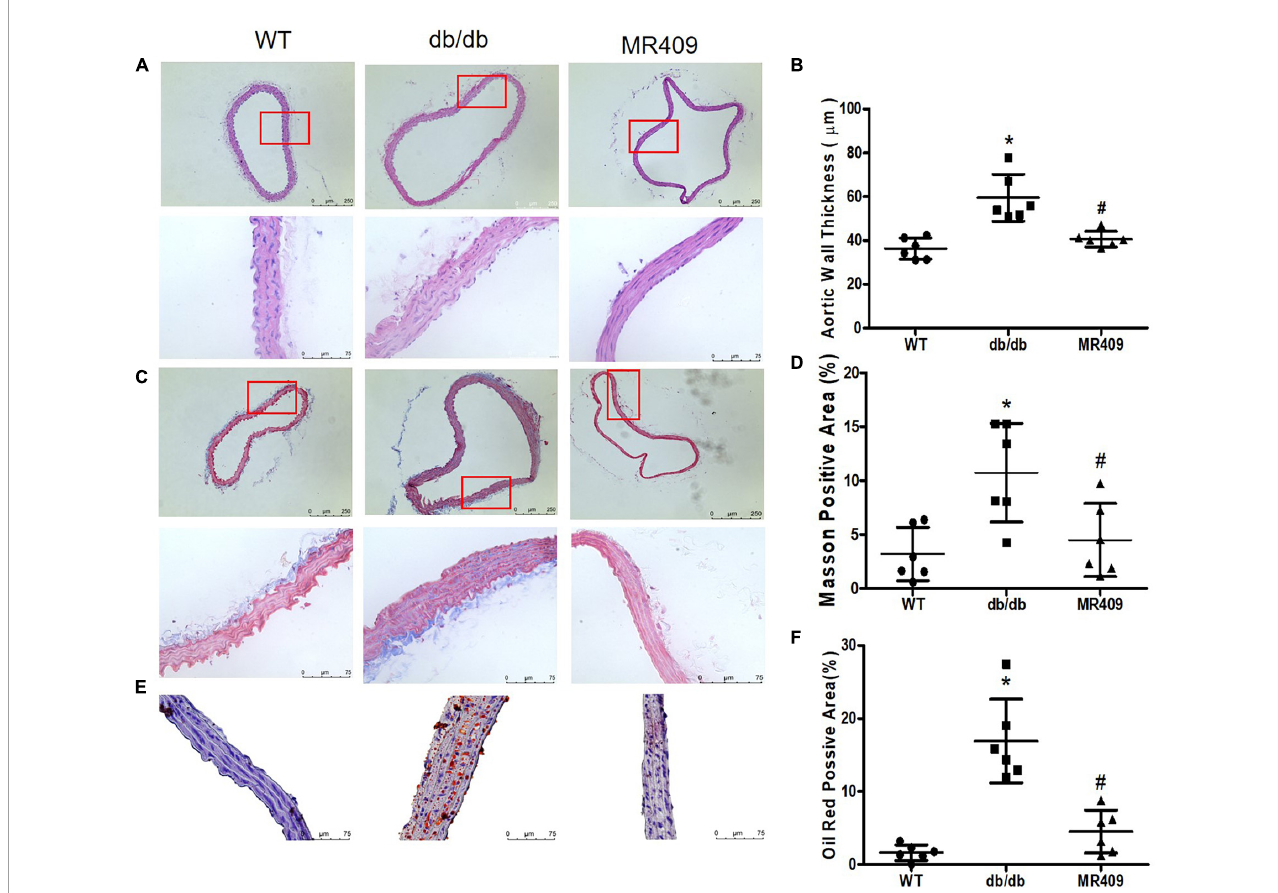
FIGURE2 Treatment with MR409 improves vascular morphological injury in diabetic db/db mice. The representative images of cross section of aortic wall stained with hematoxylin and eosin for aortic wall thickness with a low magnification in up pane and a high magnification in low pane (A) , Masson trichrome for collagen content with a low magnification in up pane and a high magnification in low pane (C) and oil O staining for lipid deposition with high magnification (E) . The quantitation of aortic wall thickness (B) , positive collagen staining areas (D) and lipid deposition (F) in the aorta. N = 6, * p < 0.05 diabetic mice vs. WT mice, # p < 0.05 MR409 treated mice vs. diabetic